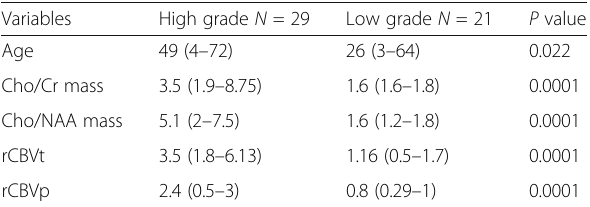
Table 2 Descriptive statistics for high- and low-grade gliomas regarding the overall rCBV ratios and spectroscopic data Variables